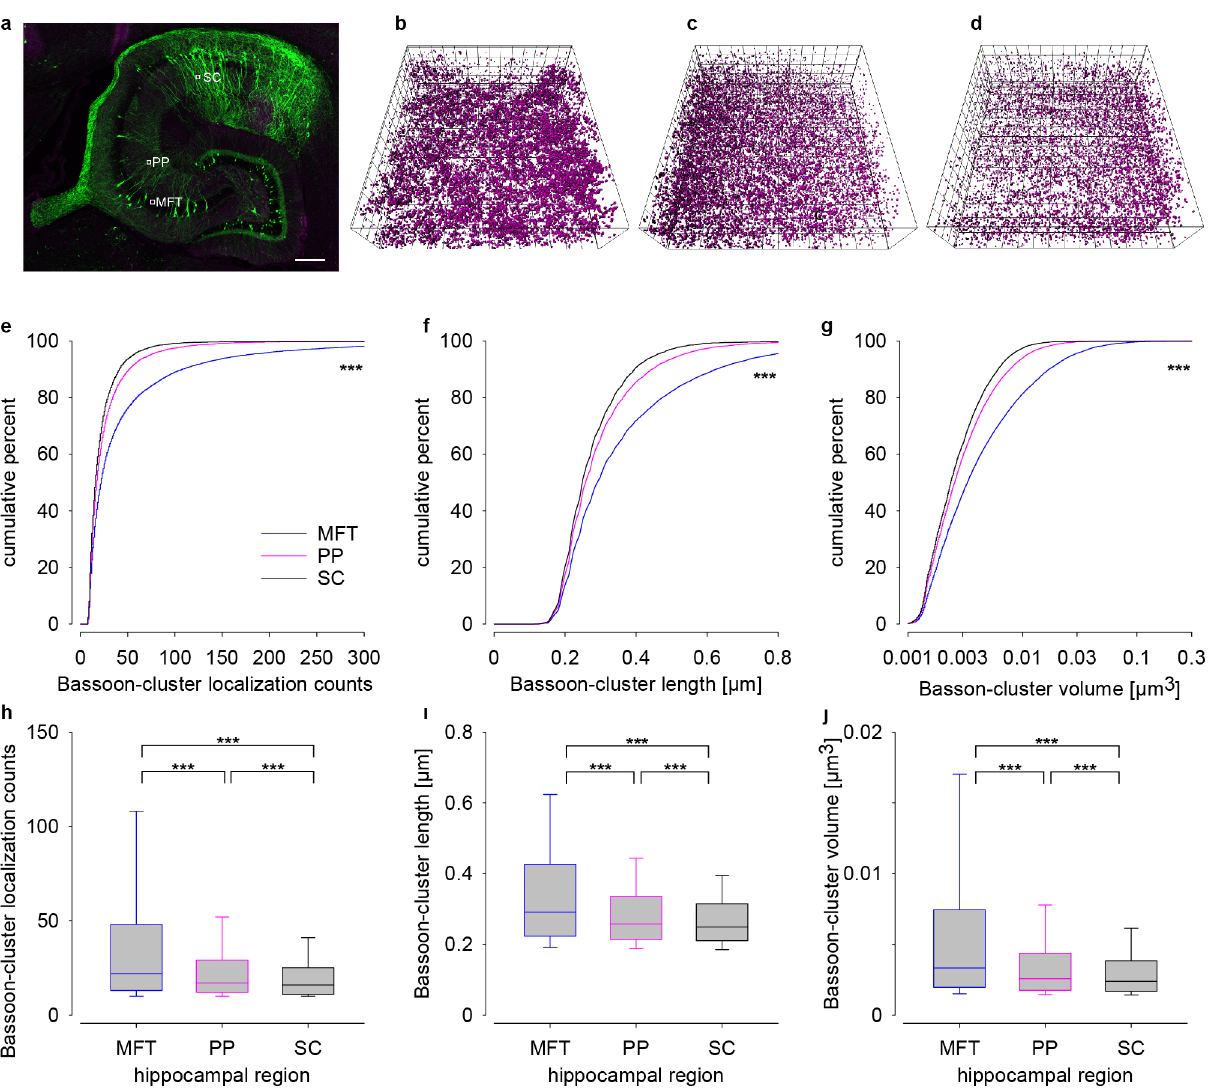
Fig. 4 En bloc 3D imaging in 25 µ m thick tissue slice revealed different Bassoon patterns in three distinct hippocampal circuits. a Confocal overview of a 25 µ m thick section of the hippocampus in a Thy-1 EGFP(M) mouse with imaging windows in the mossy fi ber tract (MFT), perforant pathway (PP), and Schaffer collaterals (SC) depicted to scale (25 × 25 µ m). 3D plots of Bassoon clusters in MFT ( b ), PP ( c ), and SC ( d ). Cumulative plots of localization counts ( e ), cluster length ( f ), and volumes ( g ) in MFT (blue), PP (magenta), and SC (black). Corresponding data as box plots in h – j Scale bar: 200 µ m in a and grid size 2 µ m in b – d . Asterisks (*** p < 0.001) denote statistical signi fi cance MFT vs. PP/SC and PP vs.